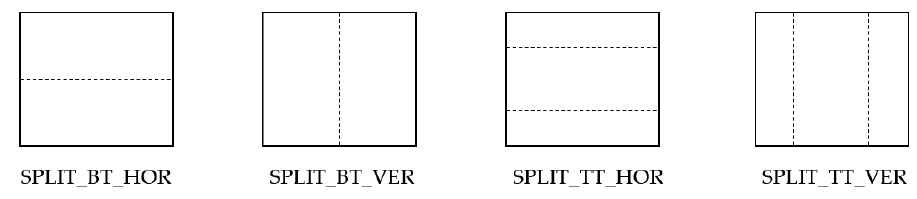
Figure 1. Four MTT splitting types in VVC.